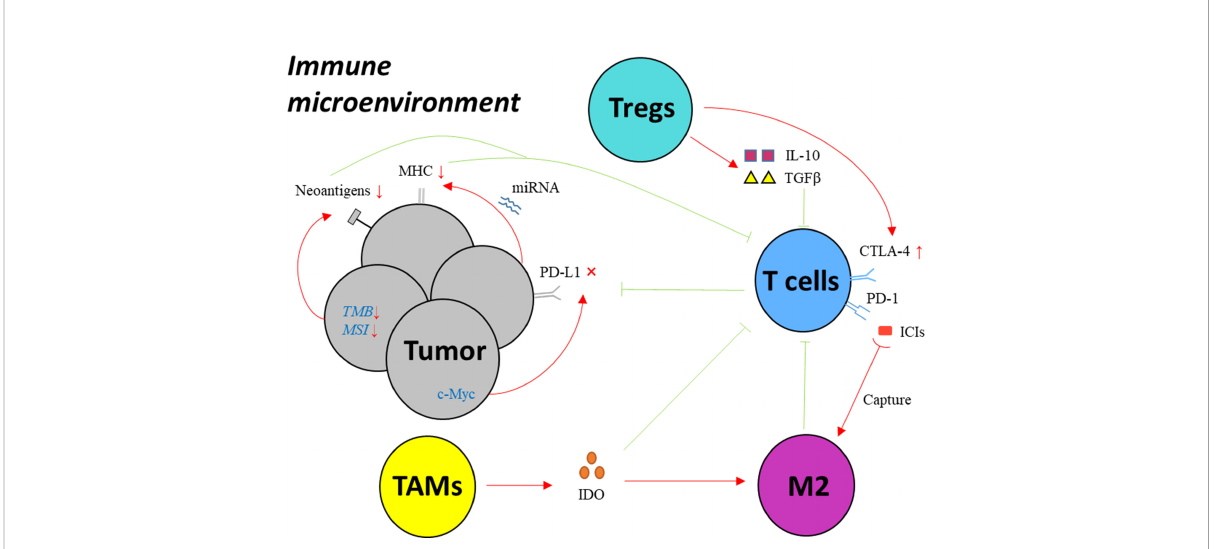
FIGURE 1 Key mechanisms of drug resistance to PD-1/PD-L1 inhibitors in EC. MHC: major histocompatibility complex; PD-1, programmed cell death protein 1; PD-L1, programmed death-ligand 1; IFN- g , interferon gamma; CTLA-4, cytotoxic T-lymphocyte-associated protein 4; Treg, regulatory T cell; IDO, indoleamine 2,3-dioxygenase; TAM, tumor associated macrophage; M2, macrophages with M2 phenotype; ICI, immune checkpoint inhibitor; miRNA, microRNA; TMB, tumor mutation burden; MSI, microsatellite instability; TGF- b , transforming growth factor- b ; IL-10,